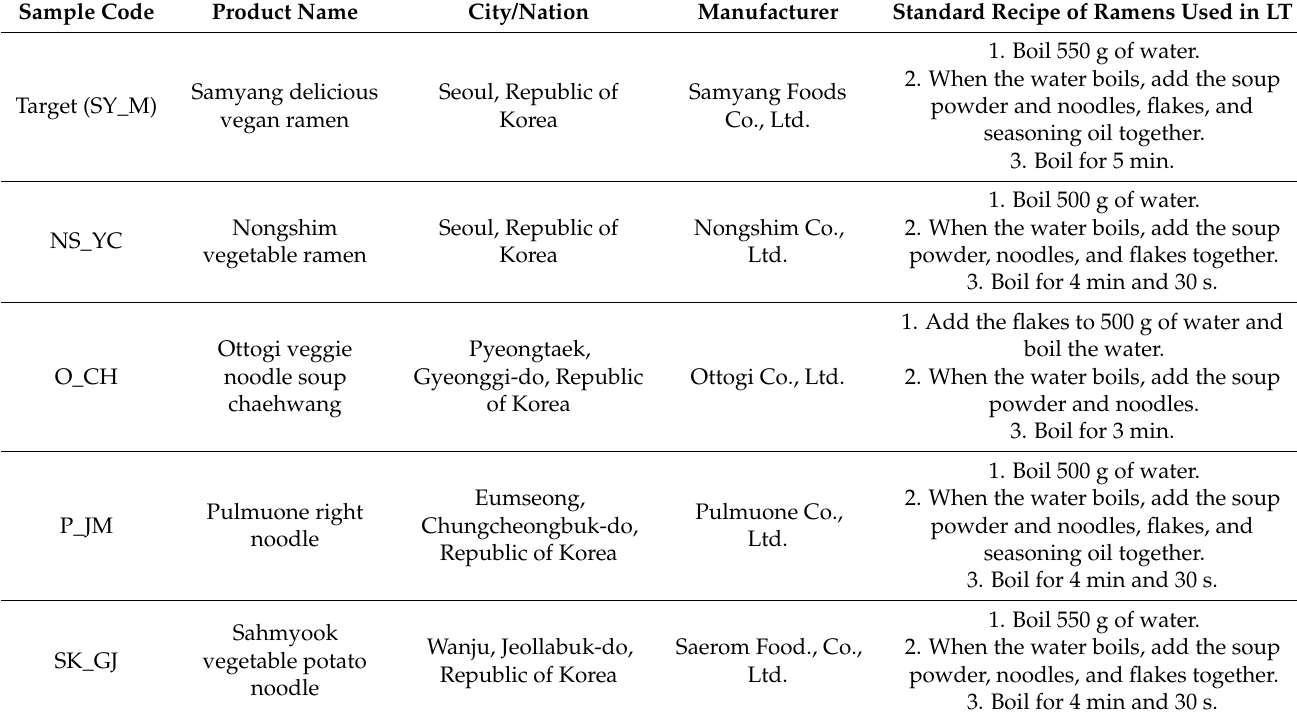
Table 2. Vegan ramen samples information and standard